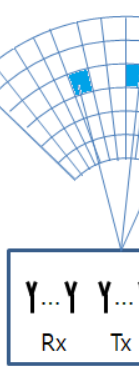
Figure 3. The R × P two-dimensional patches (range × azimuth